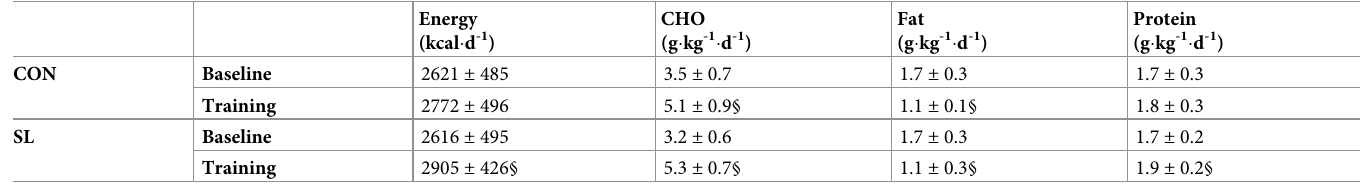
Table 5. Mean daily energy and macronutrient intake for sleep low (SL) and control (CON) groups before the training programme (baseline) and during the train- ing-nutrition